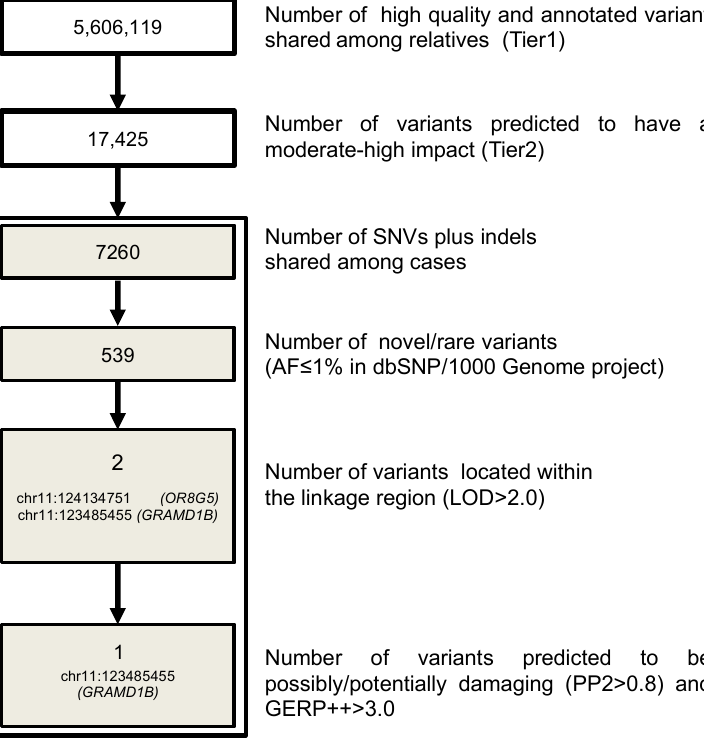
Figure 1. Pipeline for coding variant filtering. The different steps used to filter genetic variants in coding regions and the number of remaining variants in the family are reported. AF: allele frequency.